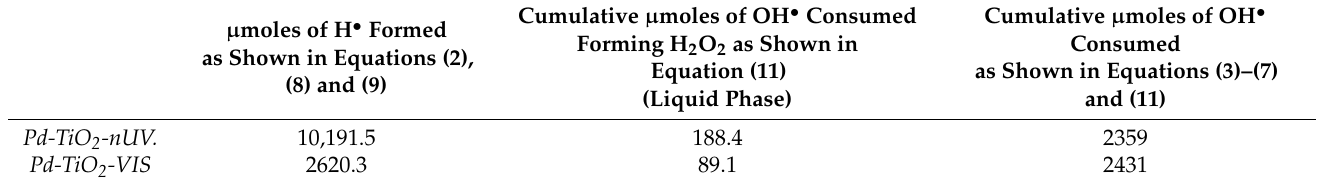
irradiation). Conditions: argon atmosphere.